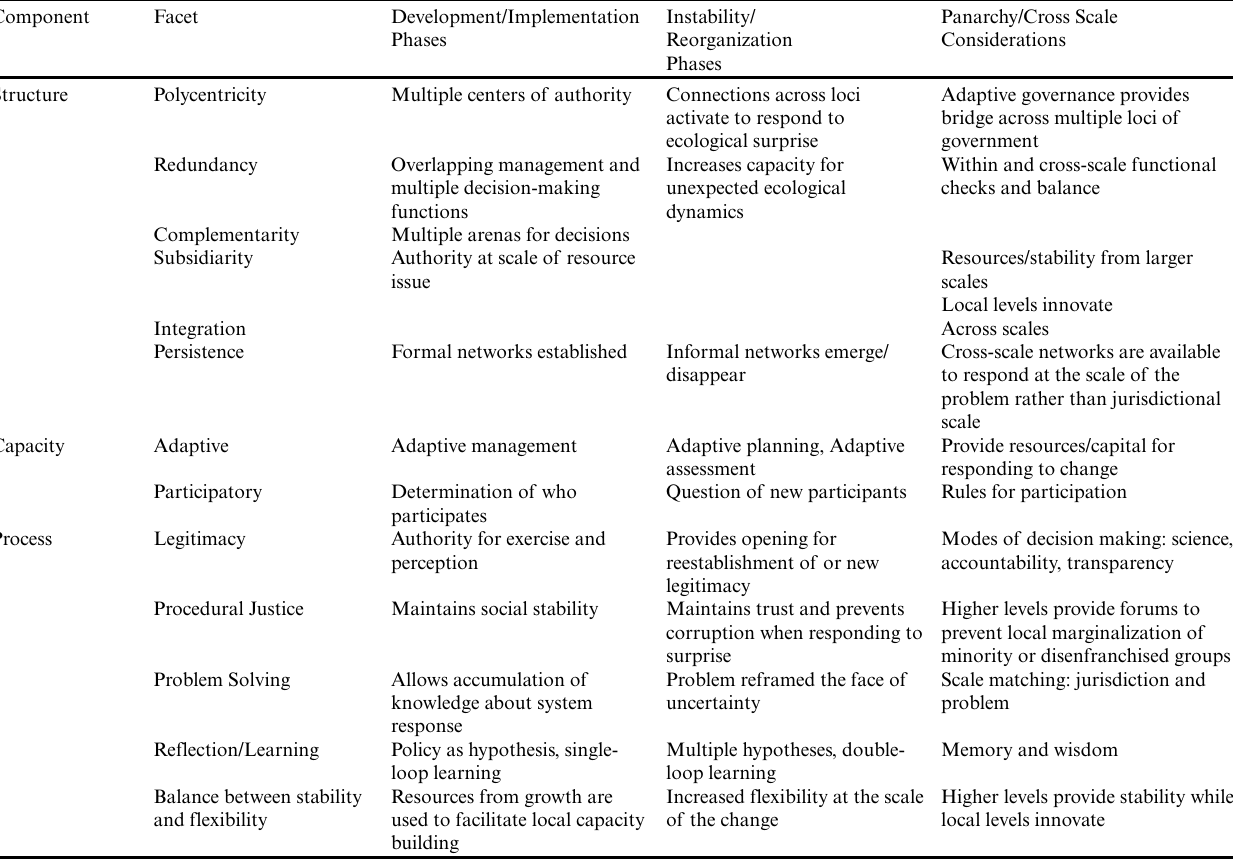
Table 2 . Relationships between components of the role of law in adaptive governance and panarchy theory, emphasizing how structures, capacities, and processes of government need to vary with phases of system development and cross-scale